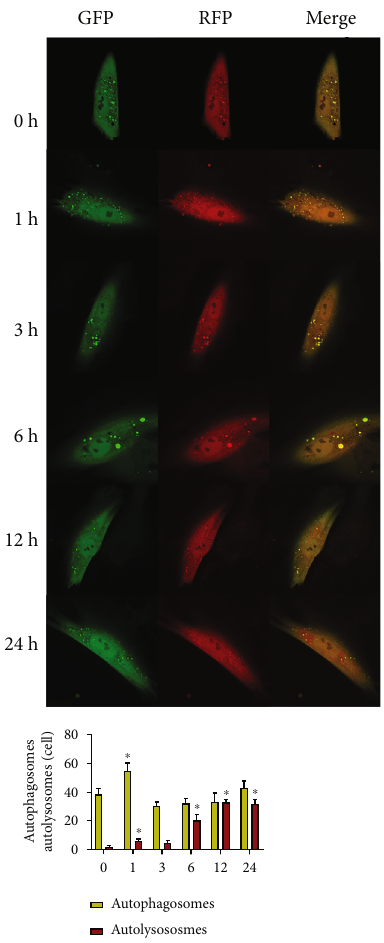
Figure 4: The detection of autophagy fl ux. ∗ P < 0 : 05 . GFP: green fl uorescent protein; RFP: red fl uorescent